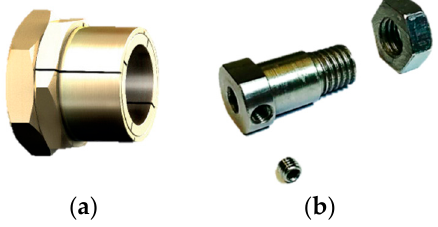
Figure 11 . ( a ) KTR Clampex 131, ( b ) custom made alternative. Figure 11. ( a ) KTR Clampex 131, ( b ) custom made